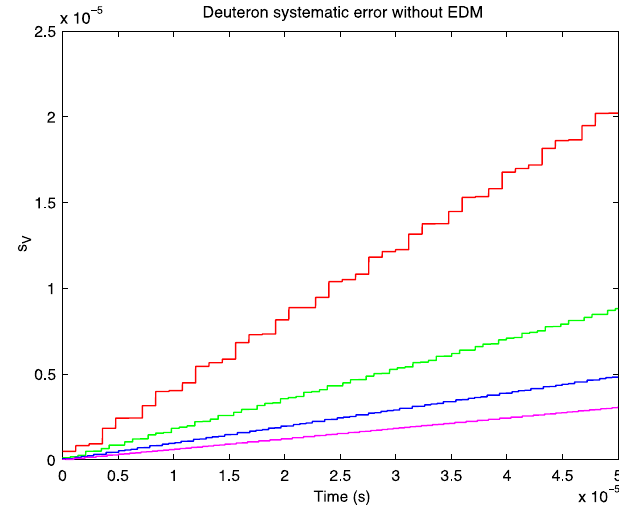
FIG. 1. The vertical spin component, s , normalized to 1, vs FIG. 2. The vertical spin component, s , normalized to 1, vs V V time for the deuteron, assuming an EDM of 10 (cid:1) 18 e cm when time for the deuteron, assuming a misalignment angle of the magic Wien filter is on, (cid:5) ¼ 0 . In red, the momentum is 0.1 milliradian when the magic Wien filter is on. In red, the 0 : 7 GeV =c , green 1 : 4 GeV =c , blue 2 : 1 GeV =c , and magenta momentum is 0 : 7 GeV =c , green 1 : 4 GeV =c , blue 2 : 1 GeV =c , 2 : 8 GeV =c . The EDM signal is the slope of the vertical spin and magenta 2 : 8 GeV =c . The EDM-like background signal component as a function of time. The vertical oscillations are at (systematic error) is the slope of the vertical spin component the g - 2 frequency, as expected. This figure is similar to Fig. 3 for as a function of time. protons, but contains only a part of the full curve, since the EDM effect for deuterons is bigger than for protons (for the parameters given in the text).